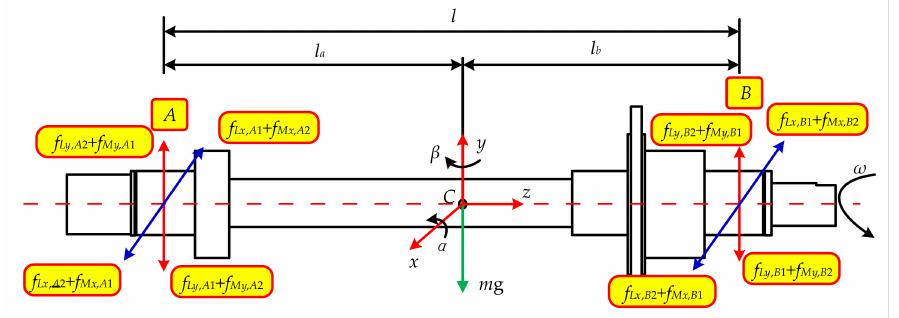
Figure 7. Force diagram of the